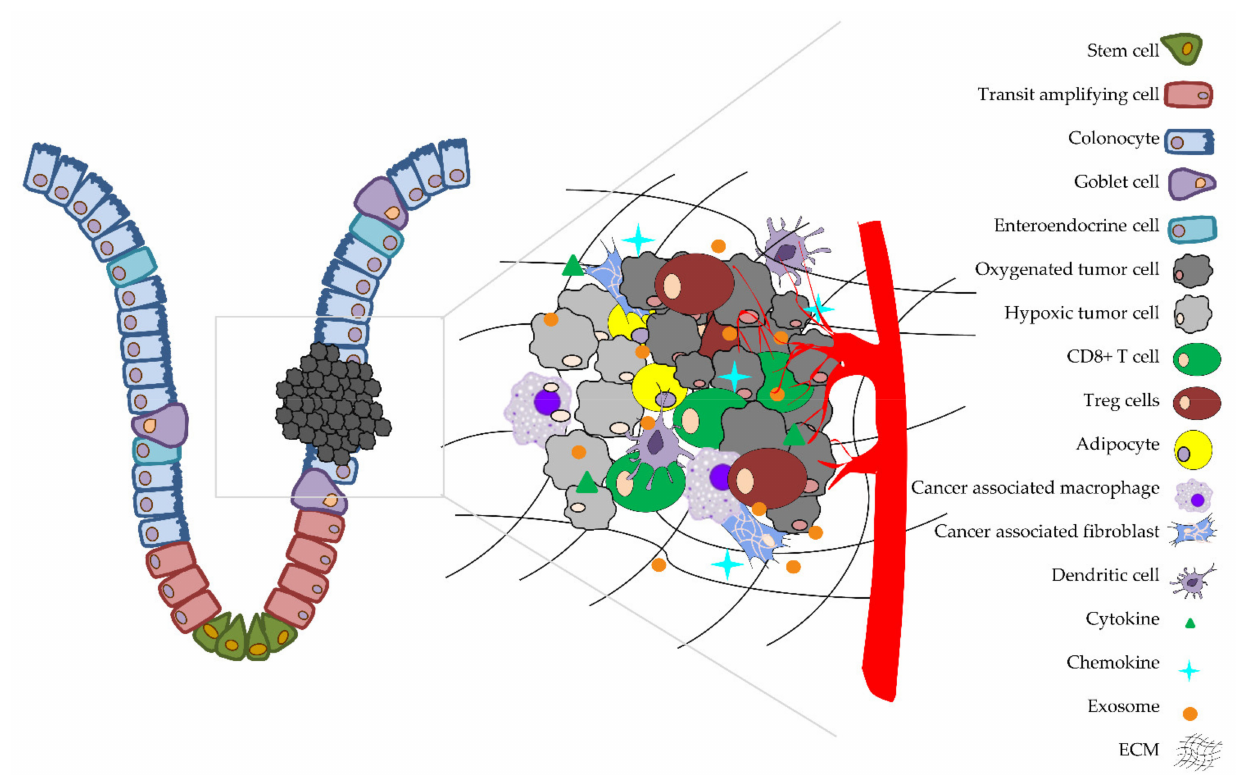
Figure 4. Depiction of tumor mass localized in the colon. Zoomed-in illustration of the tumor microenvironment (TME), including tumor cells, stromal cells and immune cells. Tumor cells with proximity to the blood vessel are marked as oxygenated while distant cells are referred to as hypoxic. The complex networking contains different types of cells, an extracellular matrix (ECM) and molecules such as cytokines, chemokines and microvesicles (such as